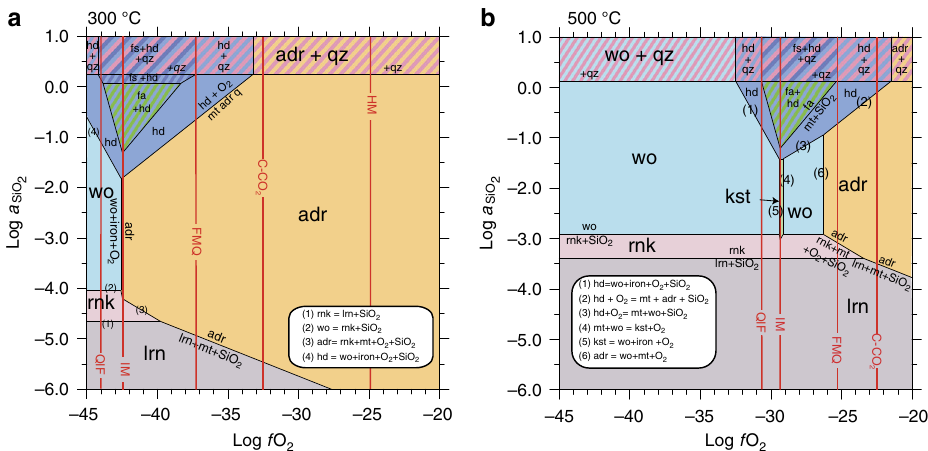
Fig. 3 Silica activity vs. oxygen fugacity plot of stable phases in the system Ca-Fe-Si-O at a 300 °C and b 500 °C at an indicative pressure of 2000 bar. Kirschsteinite is stable for T > 450 °C, relatively low silica activity and in IM-buffered conditions. Andradite is stable both in oxidative and reductive condition depending the temperature (stable in IM-buffered condition for T <